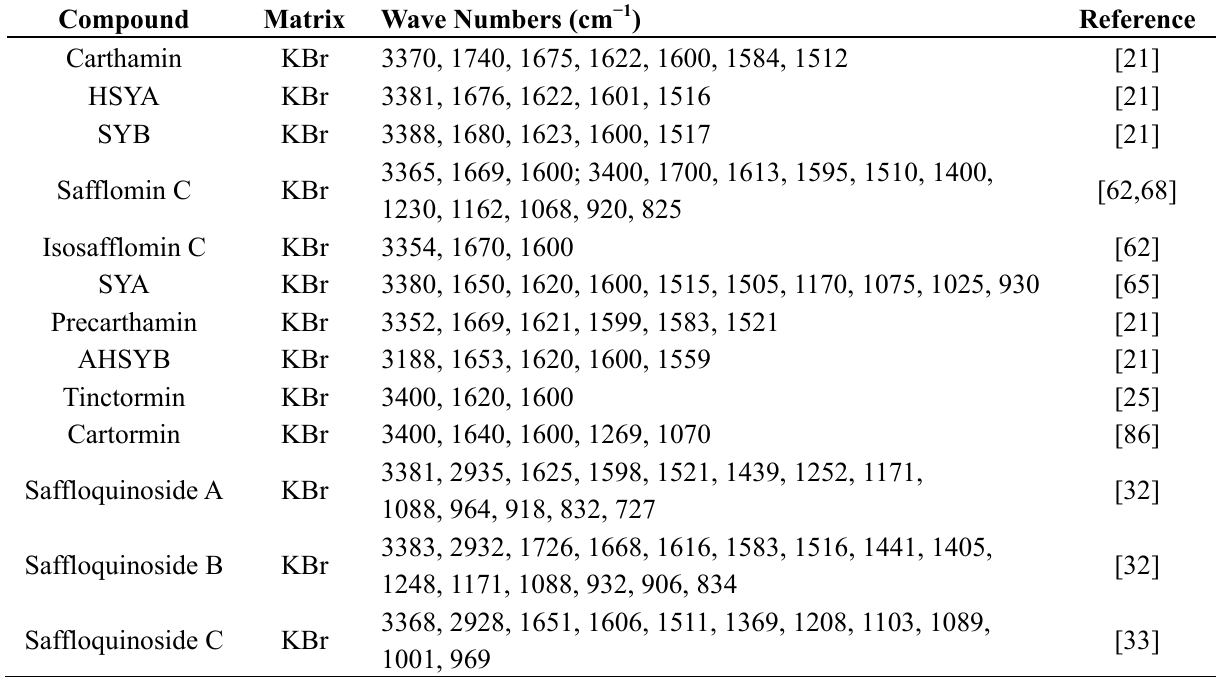
Table 8. IR spectra data of quinochalcone C